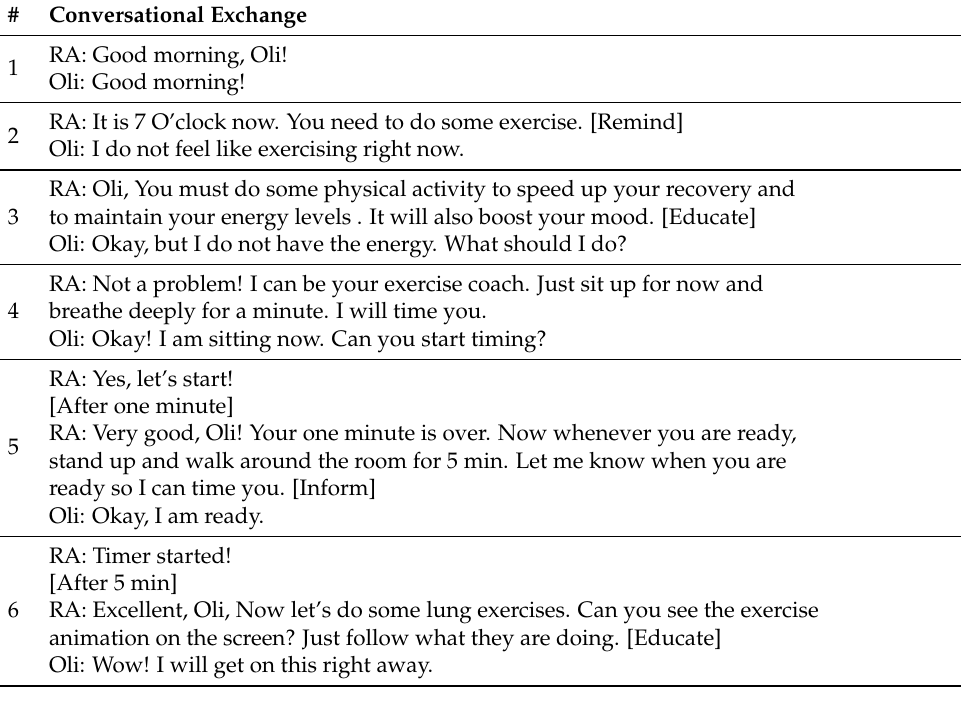
Table A5. Providing Personal